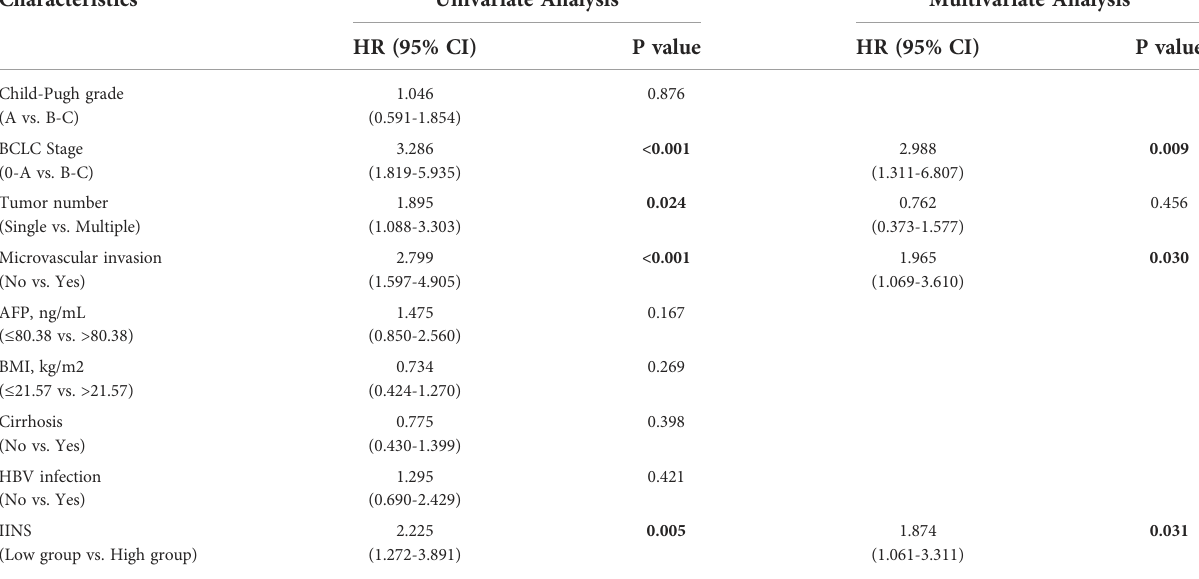
TABLE 3 Univariate and multivariate Cox regression analyses of the associations between the prognostic factors and the progression-free survival of the HCC patients.